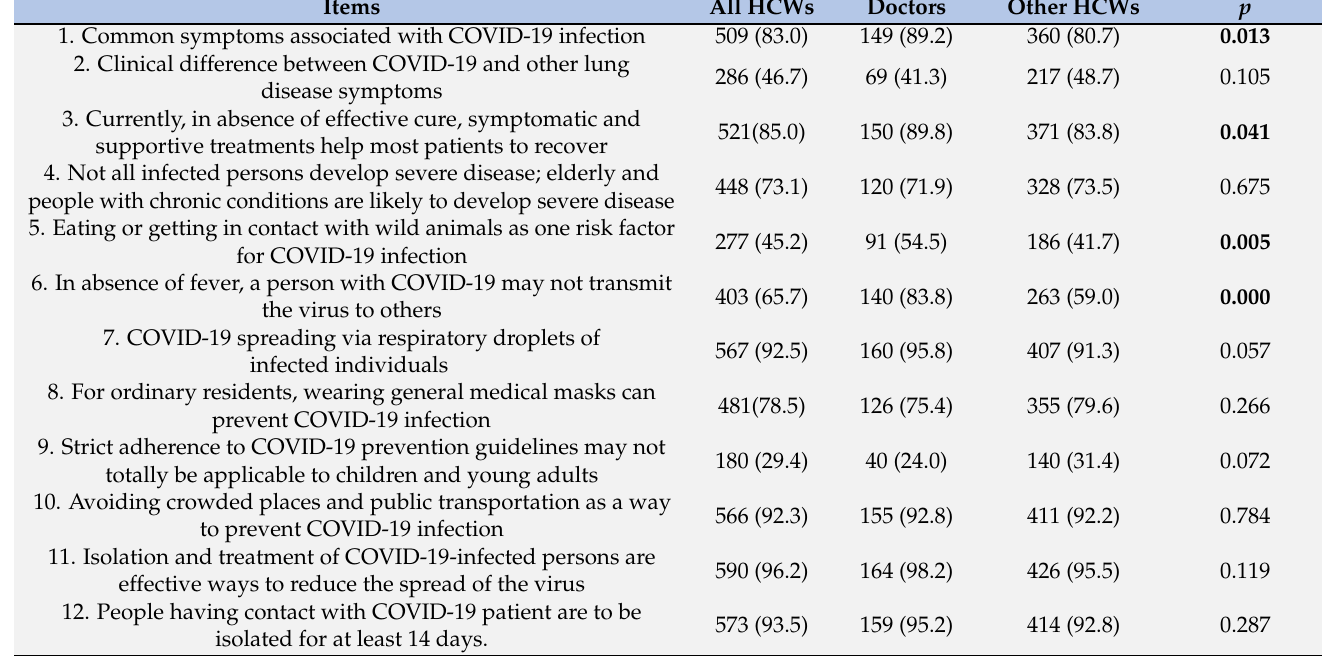
Table 2. Distribution of proportions of correct answers regarding SARS-CoV-2 (COVID-19) knowledge. Items All HCWs Doctors Other HCWs